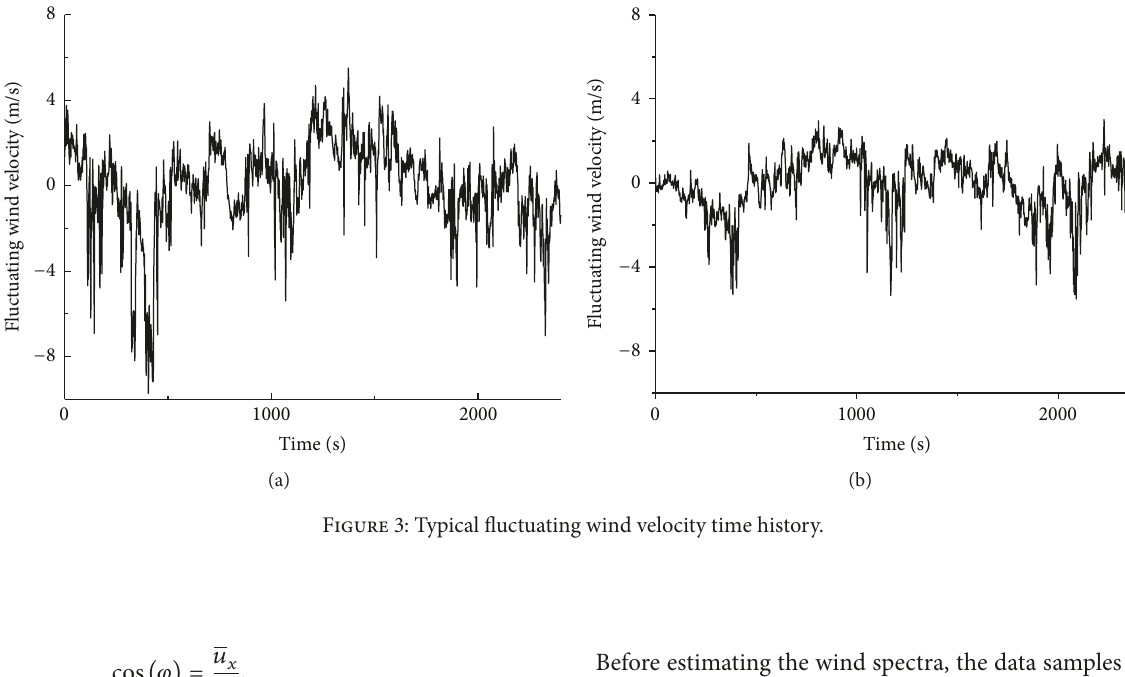
Figure 3: Typical fluctuating wind velocity time